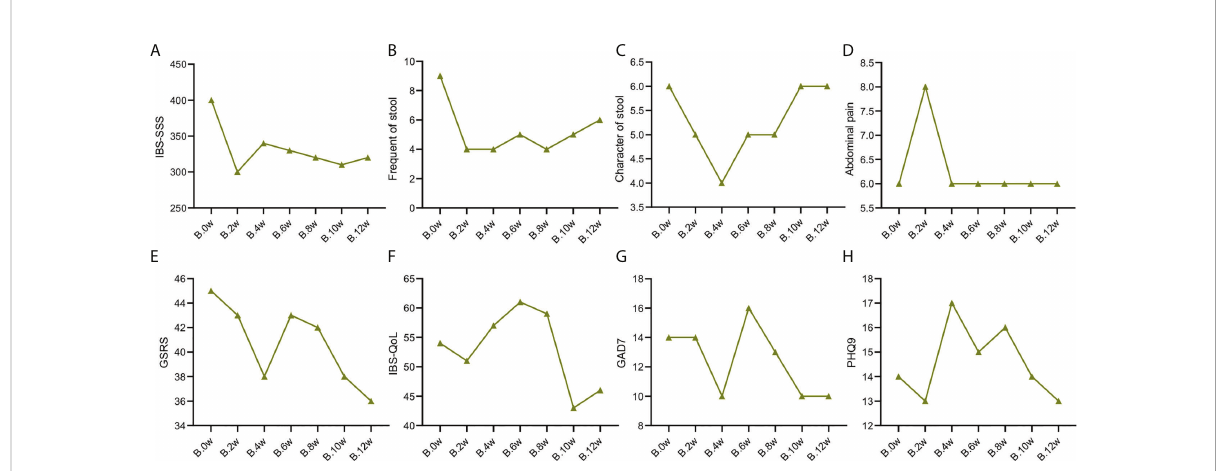
FIGURE 2 Change trend of IBS clinical indicators of patient case 2. (A) . IBS-SSS score. (B) . stool frequency. (C) . Character of stool. (D) . Abdominal pain score. (E) . GSRS. (F) . IBS-QoL. (G) . GAD7. (H) . PHQ9.